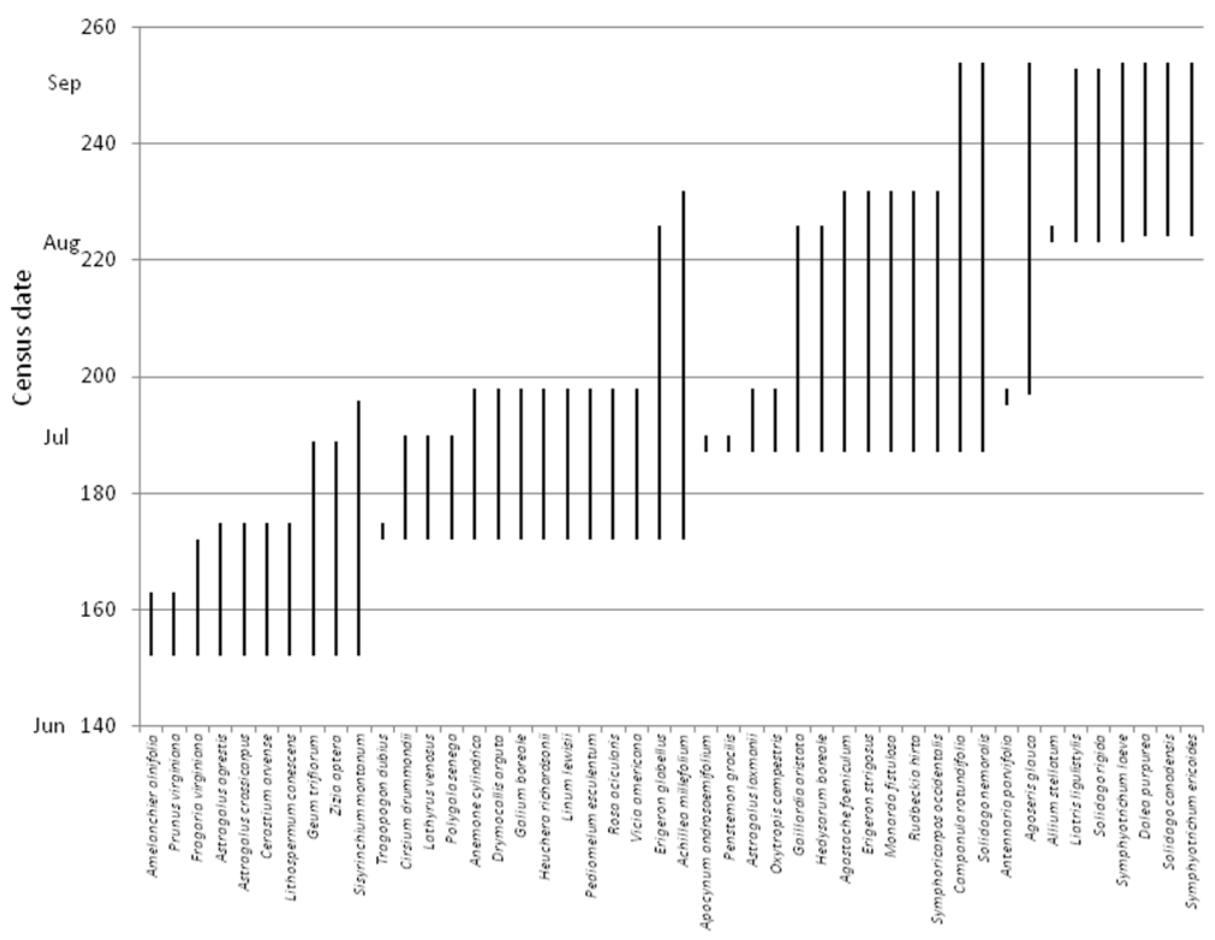
F IGURE 1. Species accumulation curves for all insect visitor taxa recorded (110), also broken down for the taxa of flies (39) and bees (29) as the most to the least generalized plants are added. Squares represent the points at which the plant species present were visited by 90% of all insect taxa in that